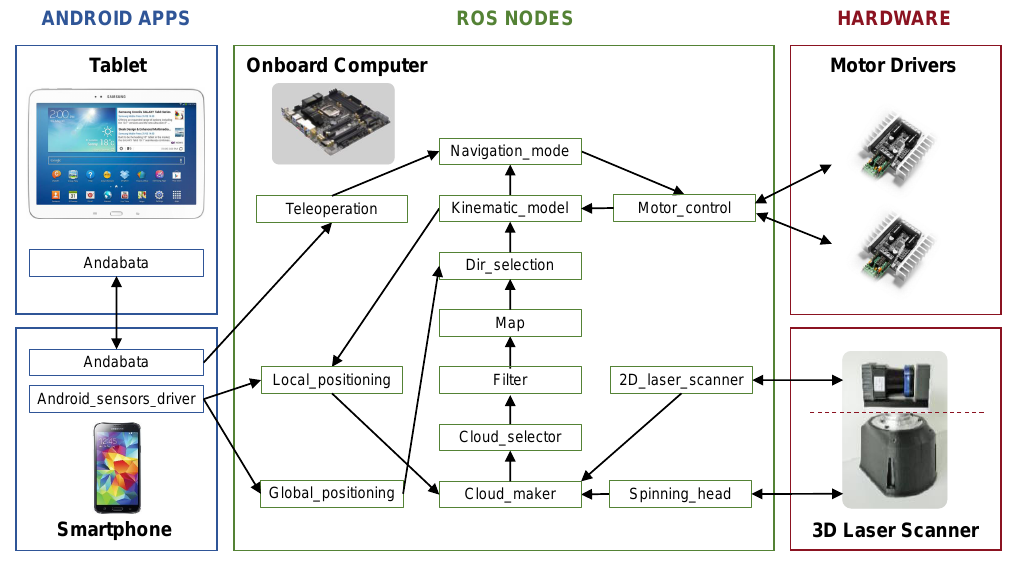
Figure 4. Software scheme of